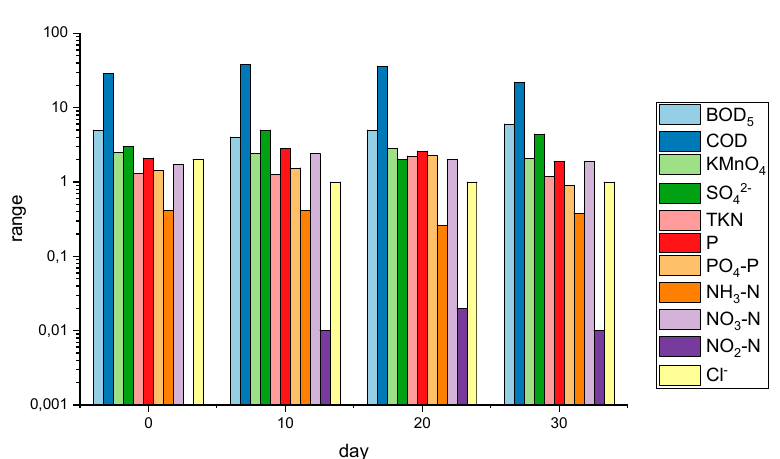
Figure 10. Changes in quantities of organic and nutrient compounds in rainwater (immediately after rainfall and 10, 20, 30 days later) used in the study.